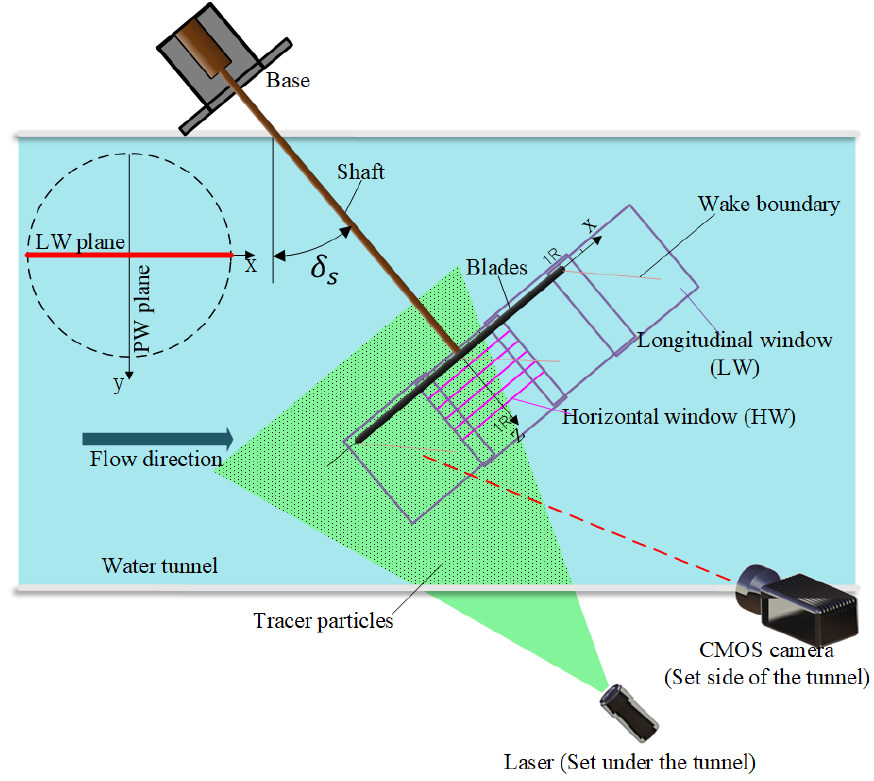
Figure 3. Longitudinal window set-up.